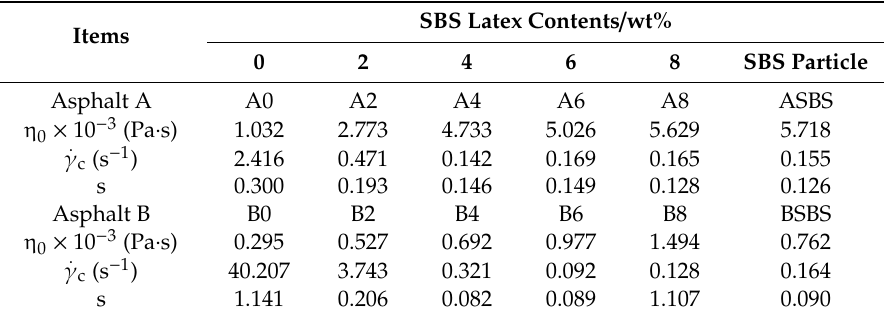
Table 3. The results calculated from the Carreau model at 60 °C of all studied samples.